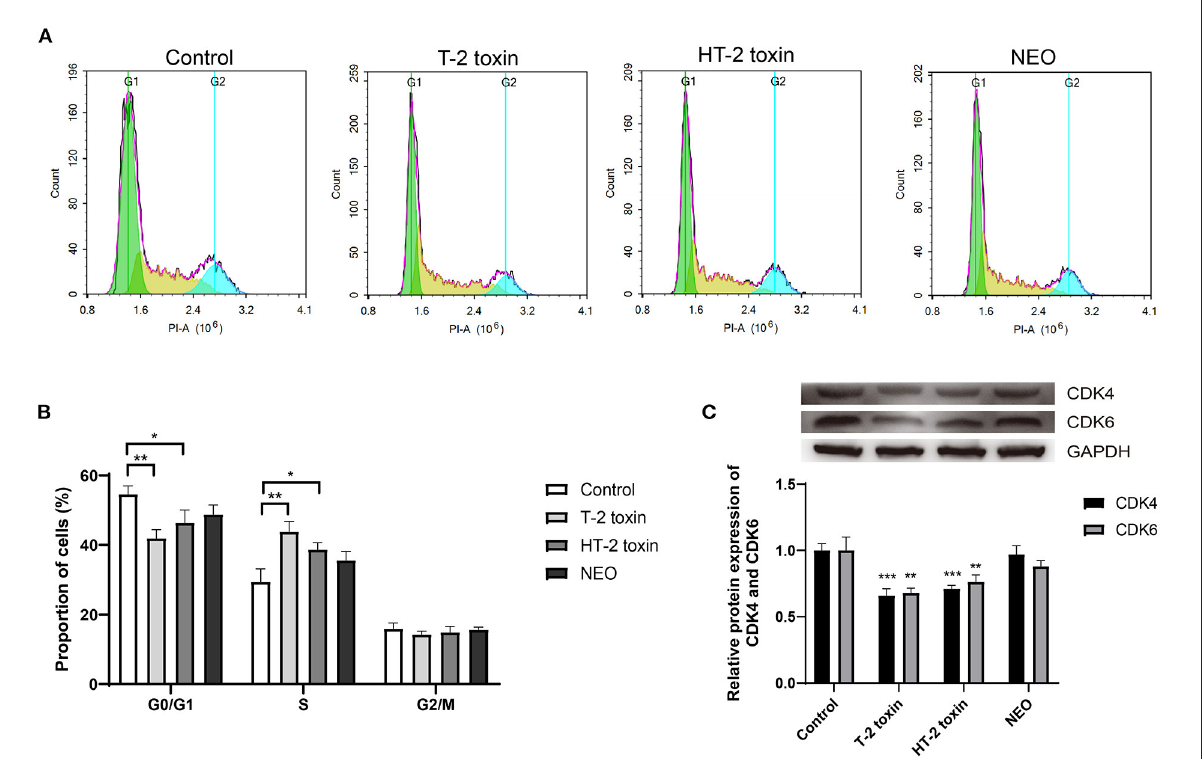
FIGURE6 Accelerated cell cycle after T-2 toxin and its hydrolytic metabolites treatment. (A) Representative cell cycle results; (B) Accelerated cell cycle at the G1 to S phase; (C) Relative protein expression of CDK4 and CDK6. C28/I2 cells were treated with 20ng/mL of T-2 toxin, HT-2 toxin and NEO, or the same volume of PBS for 24h. Data are presented as mean ± SD ( n = 6 each). * P < 0.05, ** P < 0.01, *** P < 0.001. NEO,